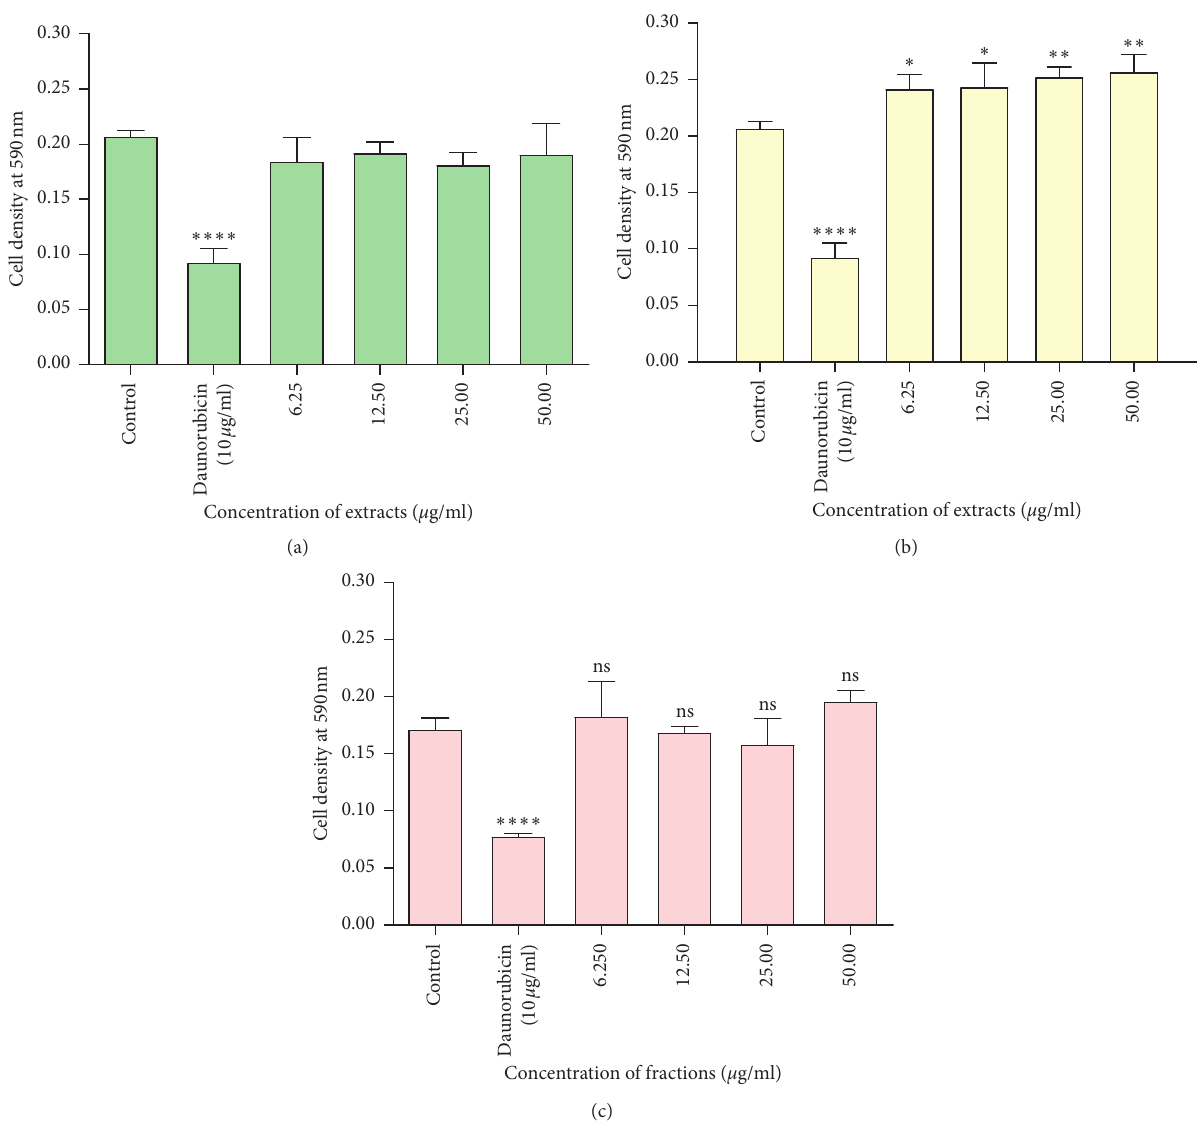
Figure 7: The effects of the leaf extract from P. curatellifolia on the viability of mouse peritoneal cells using the MTT assay. (a) Methanol extract, (b) water extract, and (c) saponin-enriched fraction. Mice peritoneal cells were plated in 96-well plates and incubated with the extracts of concentrations 6.3, 12.5, 25, and 50 µ g/ml at 37 ° C in a 5% carbon dioxide incubator. The negative control contained cells and RPMI complete media only, and positive control contained cells. The results are mean ± SD using Dunnett’s multiple range test ( p < 0 . 05) compared to control. ∗ p < 0 . 05; ∗∗ p < 0 . 01; ∗∗∗∗ p < 0 .